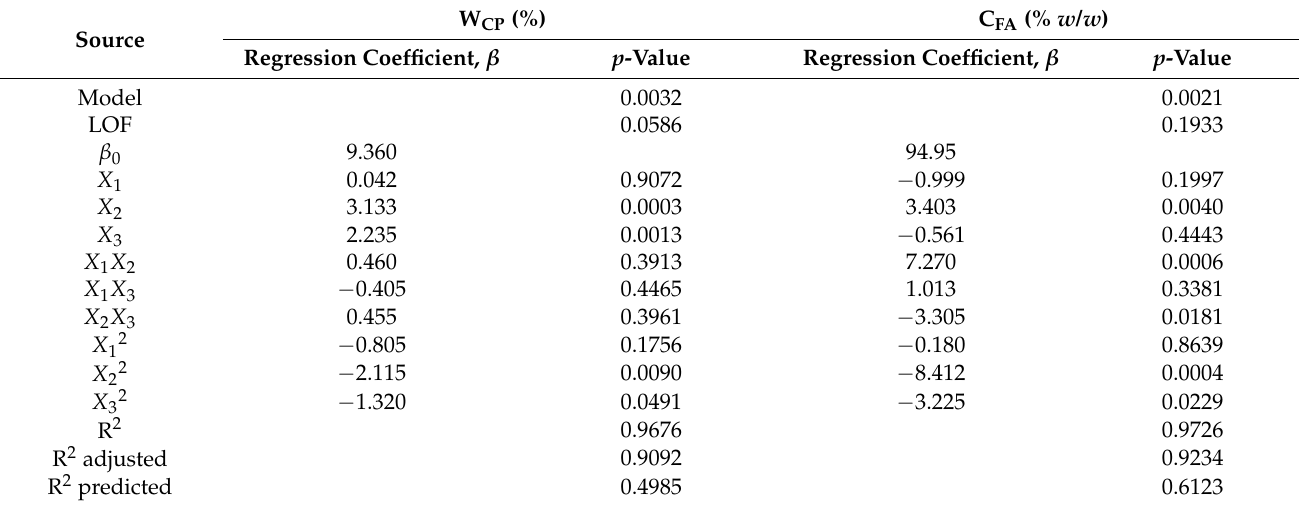
Table 2. Regression coefficients of the full square models with their statistical significance and model parameters for blackcurrant seed extraction yield (W CP ) and fatty acid content (C FA ).